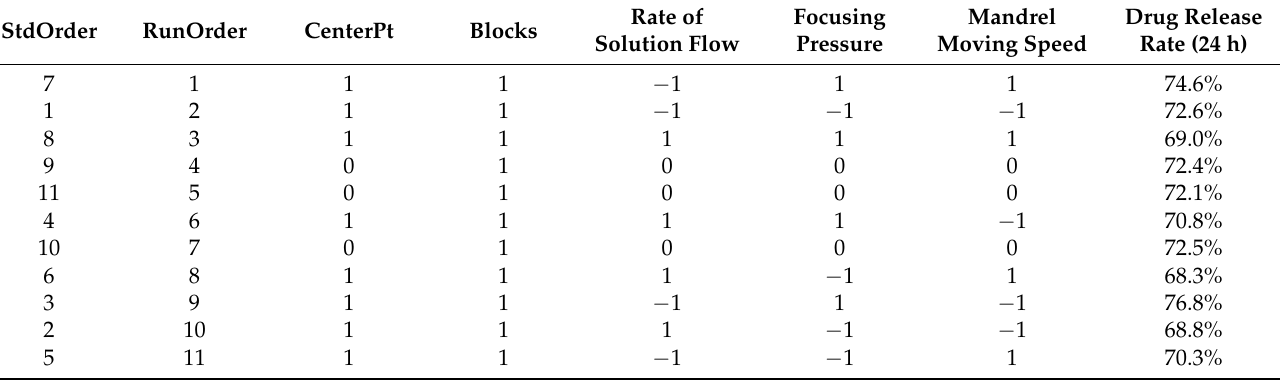
Table A2. DOE of the effects of spraying parameters on the coating drug release